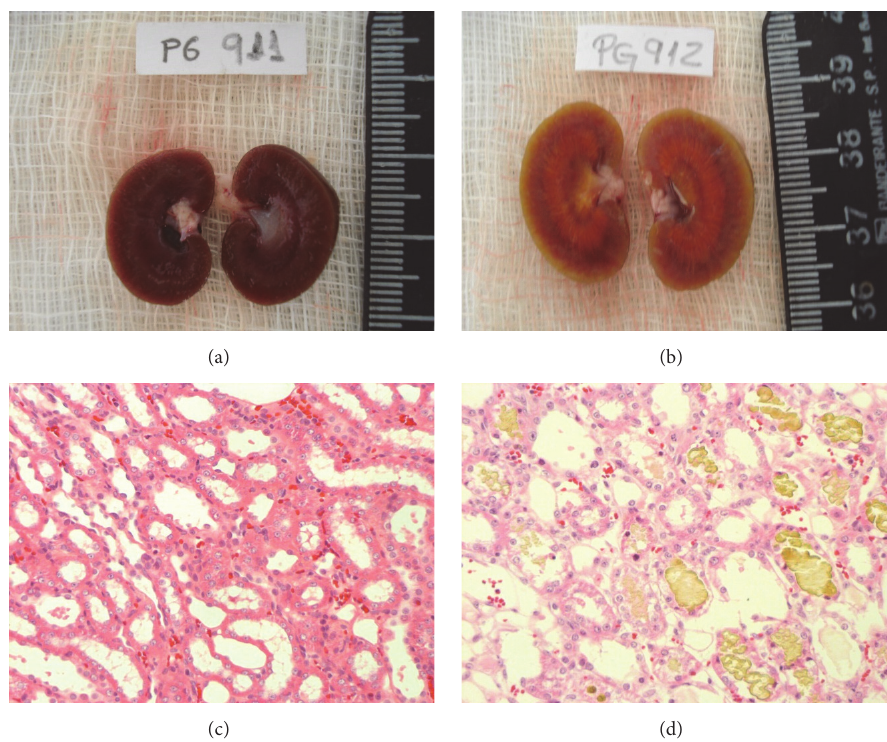
Figure 2: Development of acute renal failure. (a) Normal kidney of offspring who received vehicle; (b) kidney of offspring who received a single intraperitoneal injection of folic acid, characterized by a yellowish color and increased size; (c) normal kidney of offspring who received vehicle; (d) kidney of offspring who received a single intraperitoneal injection of folic acid, which present inside the tubules a granular and yellowish material compatible with folic